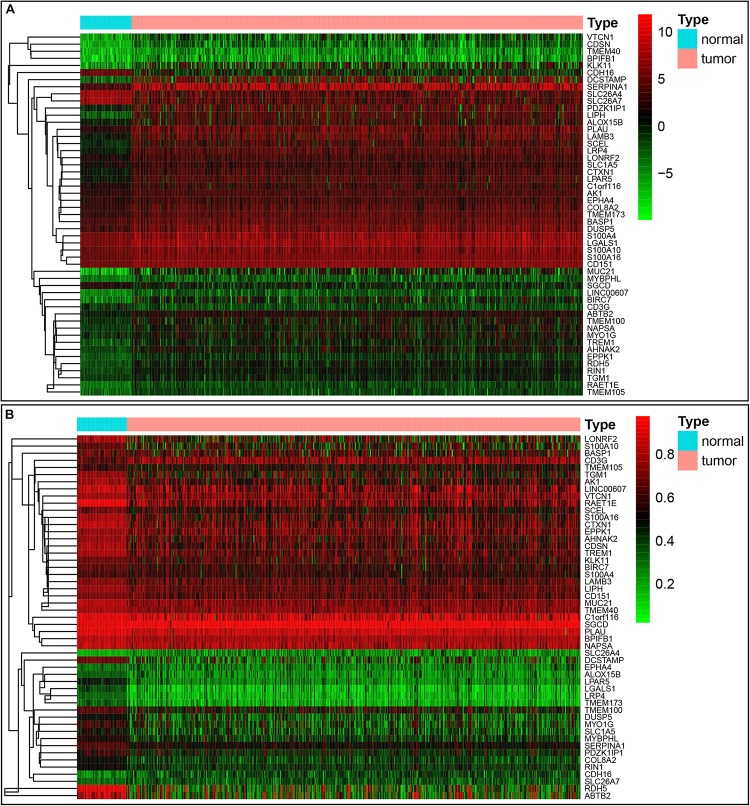
Heatmap of 51 methylation-driven genes in thyroid cancer. (A) The expression pattern of 51 methylation-driven genes. Red represents upregulated genes and green represents downregulated genes between tumor and normal tissues. (B) The methylation pattern of 51 methylation-driven genes. Red represents highly methylated genes and green represents low methylated genes between tumor and normal tissues.